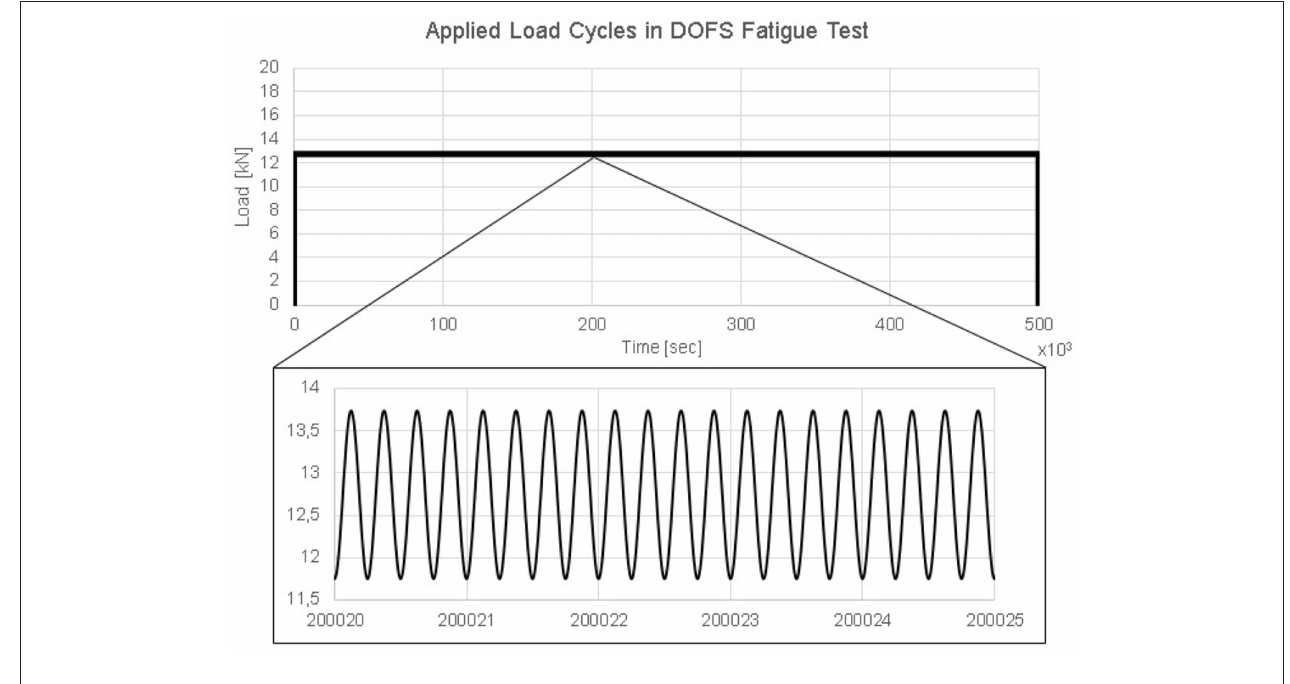
FIGURE 12 | Defined load sequence for fatigue cycles.